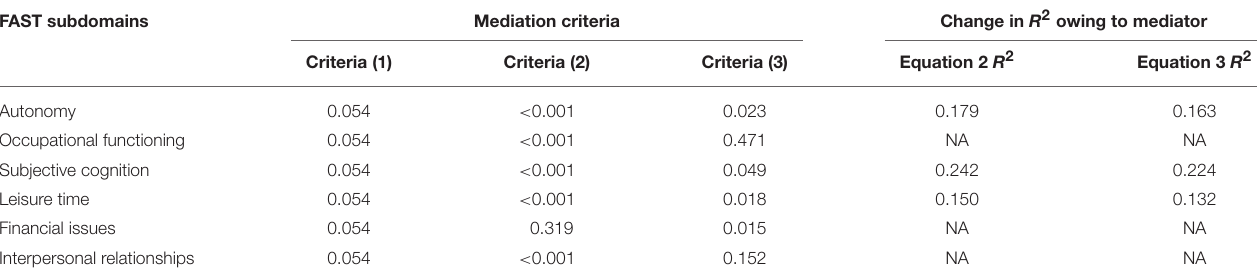
TABLE 4 | P- values for mediation criteria, and R 2 values, for the MDD status-FAST Subdomain relationship as mediated by executive functioning ( N =